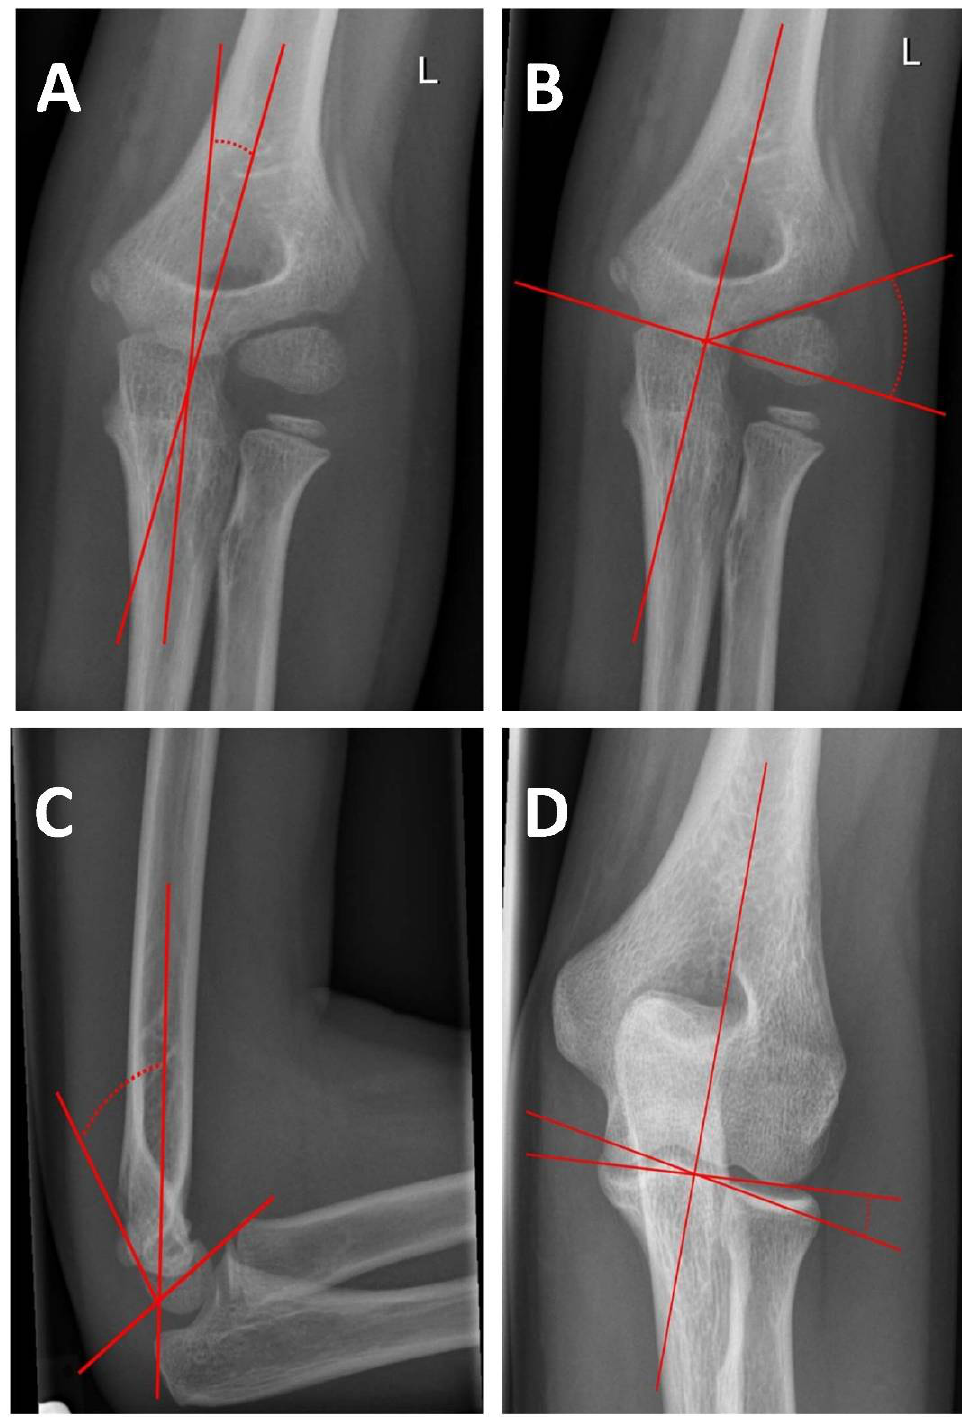
Figure 2. Angles for evaluation of reduction in supracondylar humeral fractures. ( A ): Humeral ulnar angle. An increased angle indicates elbow valgization and a decreased angle elbow varization. ( B ): Baumann’s angle. An increased angle indicates humeral varization and a reduced angle humeral valgization. ( C ): Antecurvation angle. A decreased angle indicates antcurvation and an increased angle recurvation. ( D ): Humerus trochlear angle. An increased angle indicates elbow valgization and a reduced angle elbow varization.